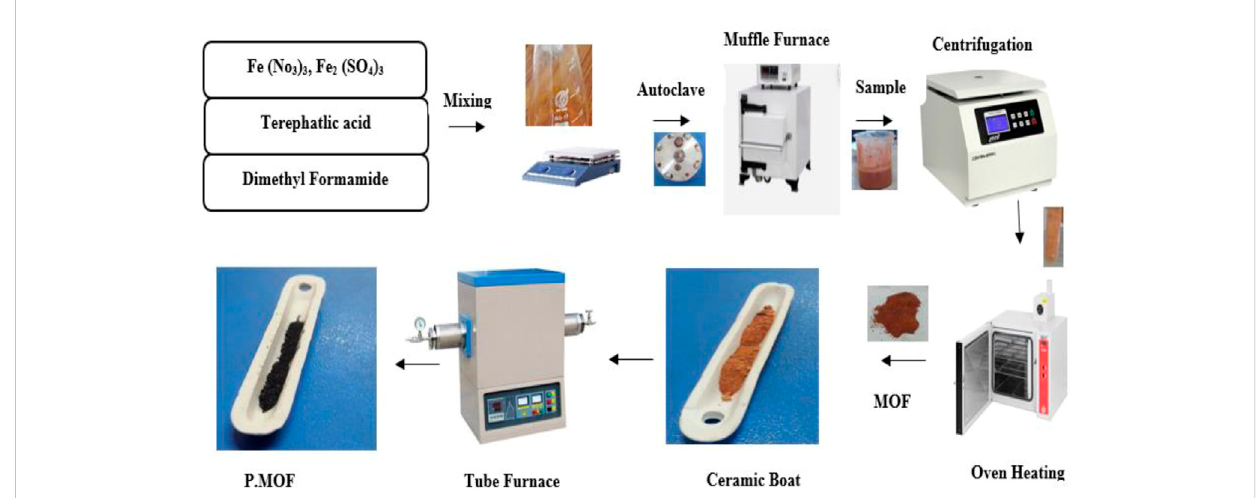
FIGURE 1 Preparation of MOFs and Pyrolysis MOFs by solvothermal method.